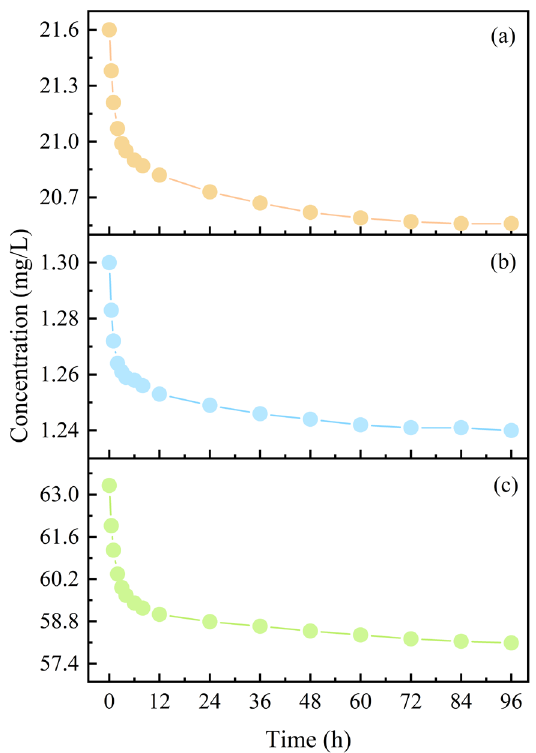
Figure 3. Removal of the contaminants with biochar alone: ( a ) TN, ( b ) TP, and ( c ) COD.